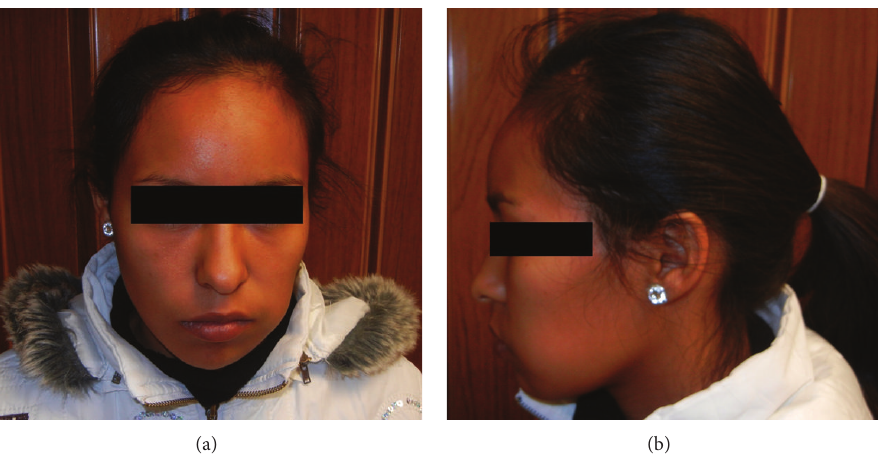
Figure 1: ((a) and (b)) Extraoral evaluation revealed a gross swelling over the left mandible.